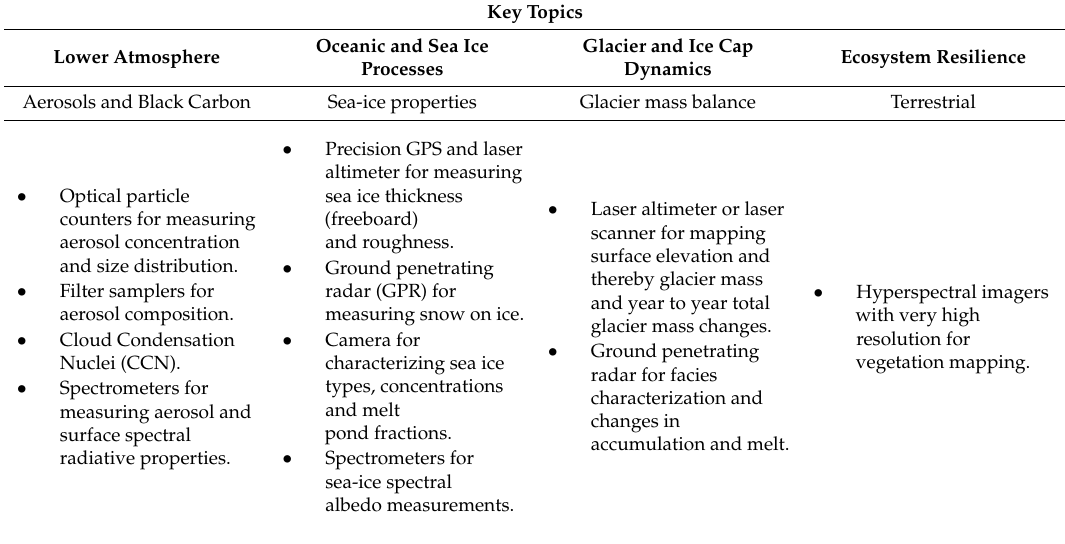
Table 2. Possible UAV capabilities in key Arctic research topics. Adapted with permission from AMAP’s Enabling Science use of UAS for Arctic Environmental Monitoring , Ch. 7